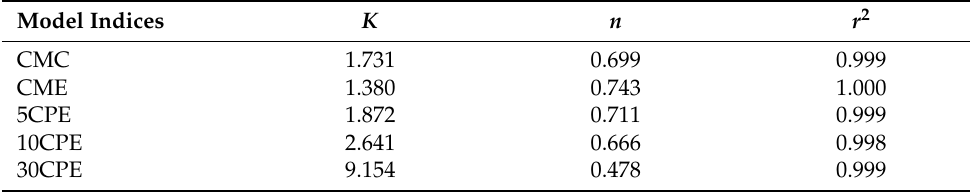
Figure 1. Apparent viscosity of OLP/CMC film-forming solutions at different shear rates. Table 2. Rheological model indices for OLP/CMC film-forming solutions .